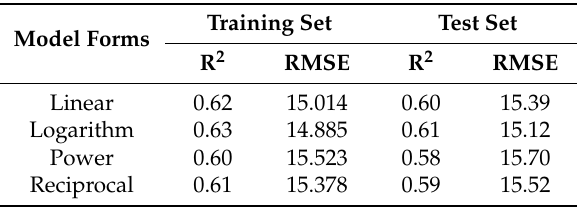
Table 6. Accuracy assessment of the different multi-factor parametric models using the 10-fold cross-validation method.